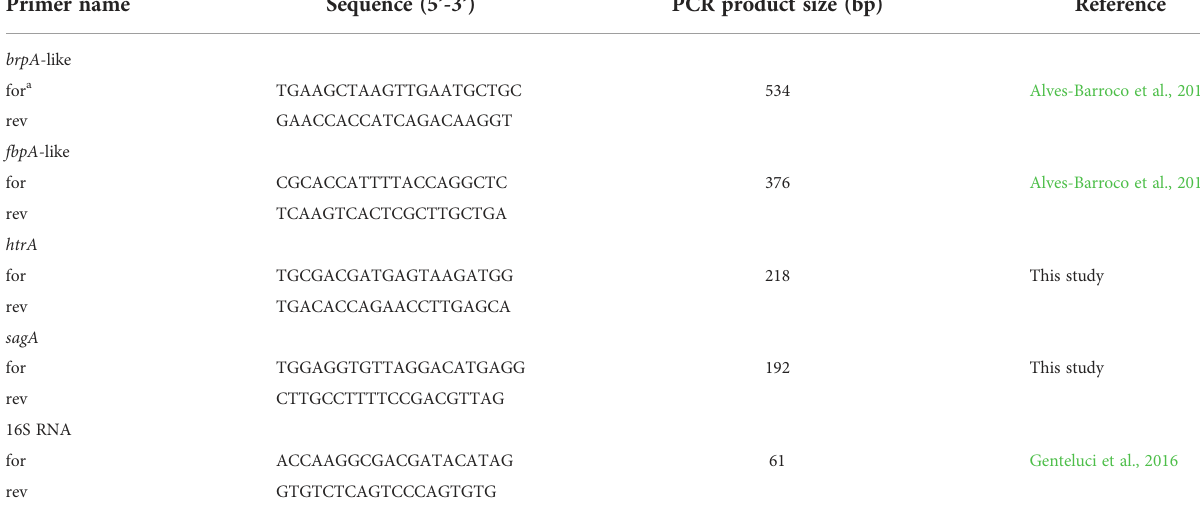
TABLE 1 Primer sequences used for RT-qPCR analysis in this